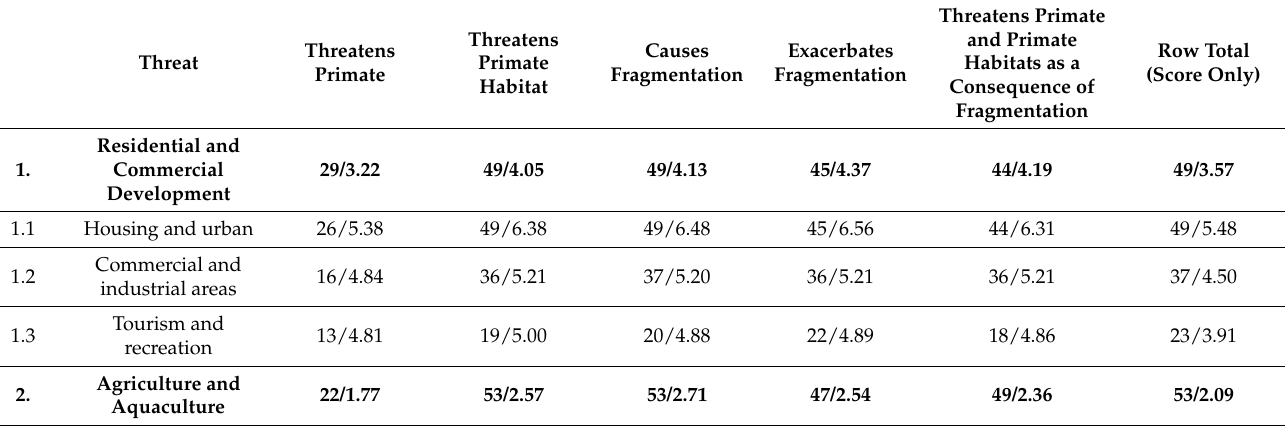
Table 1. Overall threat evaluation of Peruvian primate taxa (n = 55) using decimal threat levels for all categories and subcategories in the IUCN-CMP (# taxa affected/Score). Following the